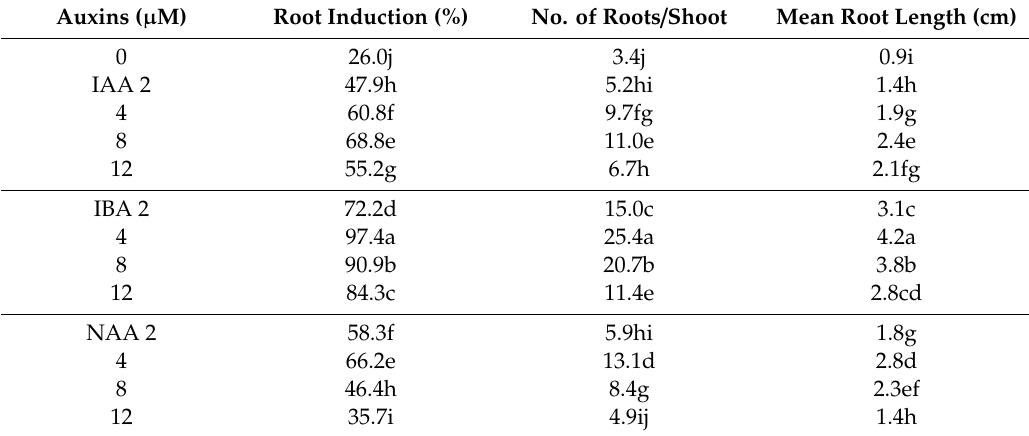
Table 3. Impacts of concentrations of auxins on in vitro rooting of Mertensia maritima . Auxins ( µ M) Root Induction (%) No. of Roots / Shoot Mean Root Length (cm)